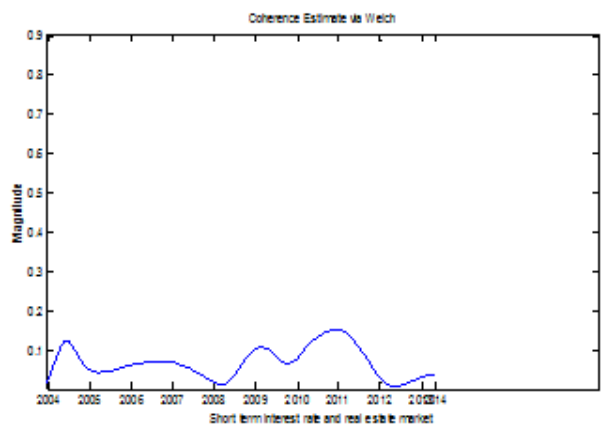
Figure 5. DCF of Short-term Interest Rate and Real Estate Market